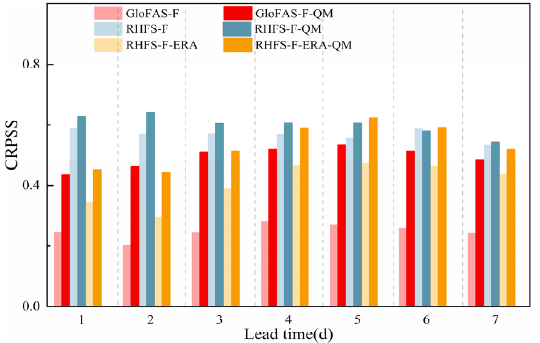
Figure 8. CRPSS (relative to sampled monthly mean climatology) of discharge reforecasts at lead times of 1–7 d during the verification period (2007, 2008, June–October). CRPSS = continuous ranked probability skill score.